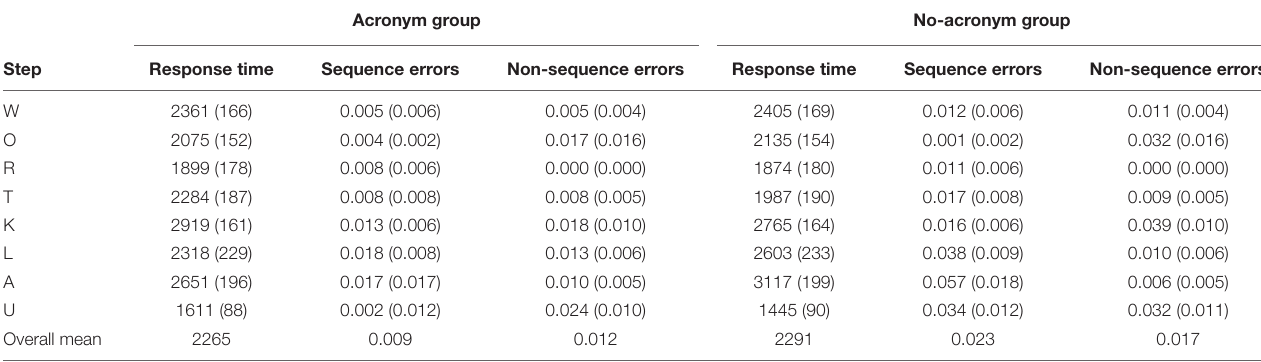
TABLE 2 | Means and standard errors (in brackets) of response times, proportion of sequence errors, and proportion of non-sequence errors at each step of the task in uninterrupted trials. In addition, resulting mean completion times and mean overall proportion of sequence and of non-sequence errors are shown for both conditions at the bottom of the